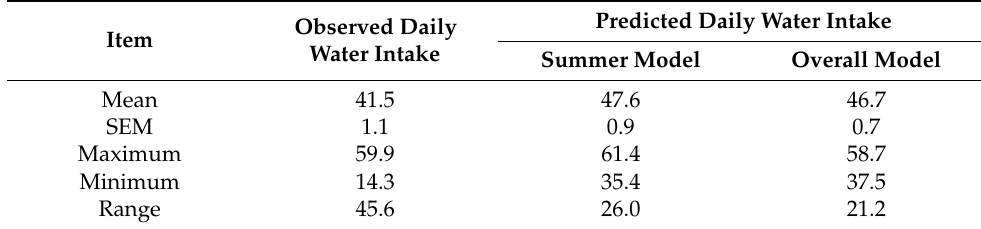
Table 3. Summary for daily water intake (DWI) for the 51-day evaluation period in Concord NE, 26 June to 15 August 2007 (L/head/d).